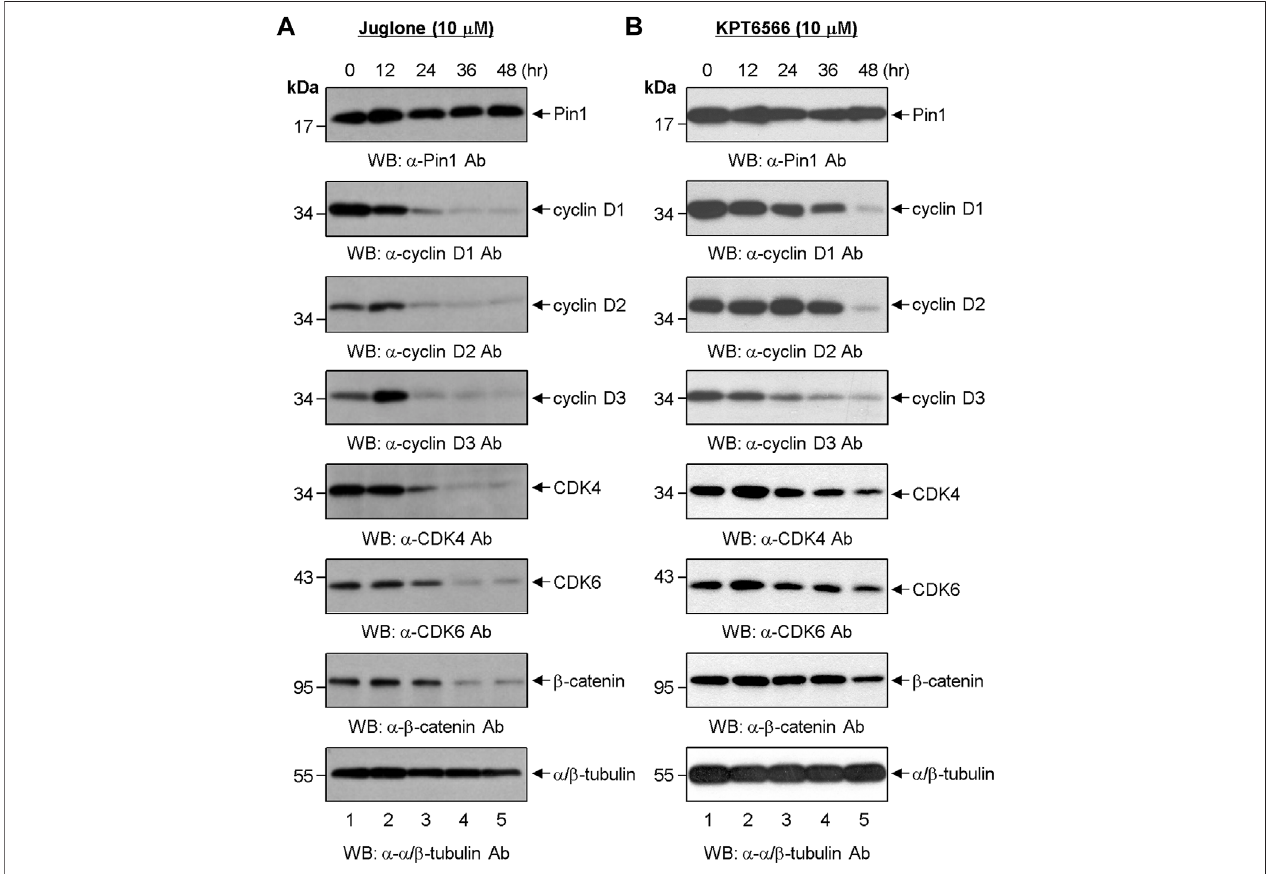
FIGURE 3 | Effect of chemical Pin1 inhibitors on expression of cell cycle regulatory proteins. (A,B) Western blot analysis of G1-Phase cell cycle regulatory proteins aftertreatmentwithJuglone. (A) orKPT6566 (B) .TotalcellextractswerepreparedfromCaco-2cellsat0,12,24,36,and48 hpost-treatmentwithJugloneorKPT6566. The cell extracts were resolved on SDS-PAGE gels (15% gels for Pin1; 12% gels for cyclin D1, cyclinD2, cyclin D3, CDK4, CDK6, and α / β -tubulin; 8%gel for β -catenin), transferred toaPVDF membrane, and immunoblotted withanti-Pin1,anti-cyclinD1, anti-cyclin D2, anti-cyclin D3, anti-CDK4, anti-CDK6, anti- β -catenin,or anti- α / β -tubulin antibodies. α / β -tubulin served as a loading control. Three independent experiments gave similar results.